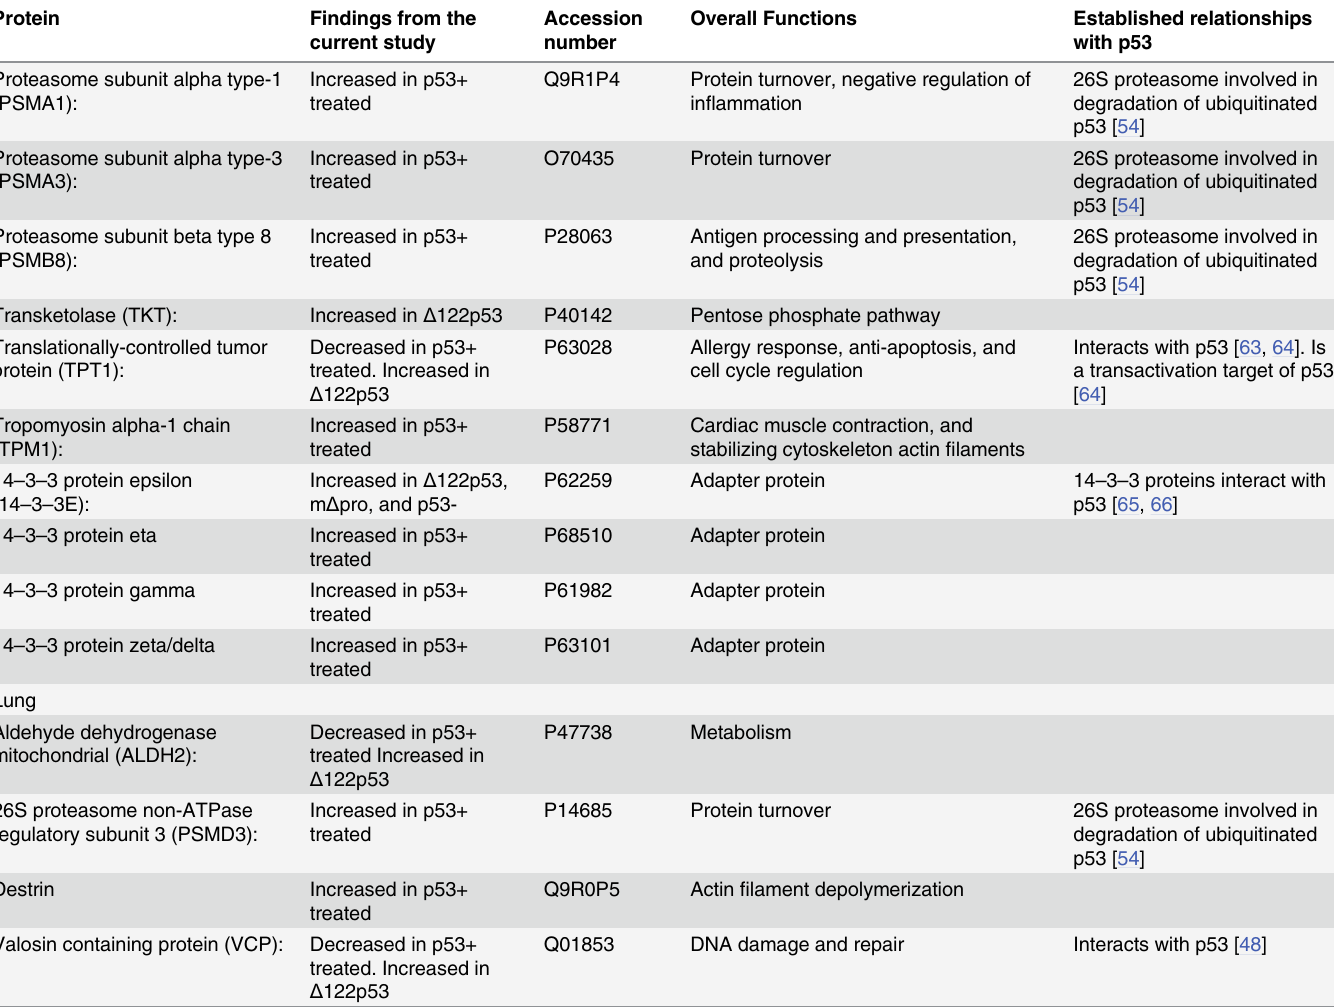
Proteins were increased or decreased at least 1.5 fold in comparison to p53 wild-type (p53+) untreated cells from the bone marrow, thymus, or lung tissue. Proteins were identified from 2D gel electrophoresis separation and MALDI-TOF mass spectrometry and peptide mass fin- gerprinting. (cid:1) , cell surface expression; in bold, proteins selected for validation using western